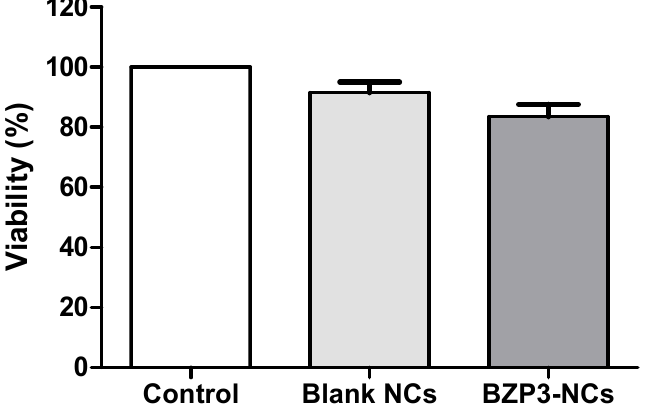
Figure 1. Cell viability of L929 fibroblast cell line treated with blank NCs and BZP3-NCs. Cytotoxicity at concentrations ranging from 10–150 µg/mL. Results are expressed as the mean ± standard deviation ( n = 4).